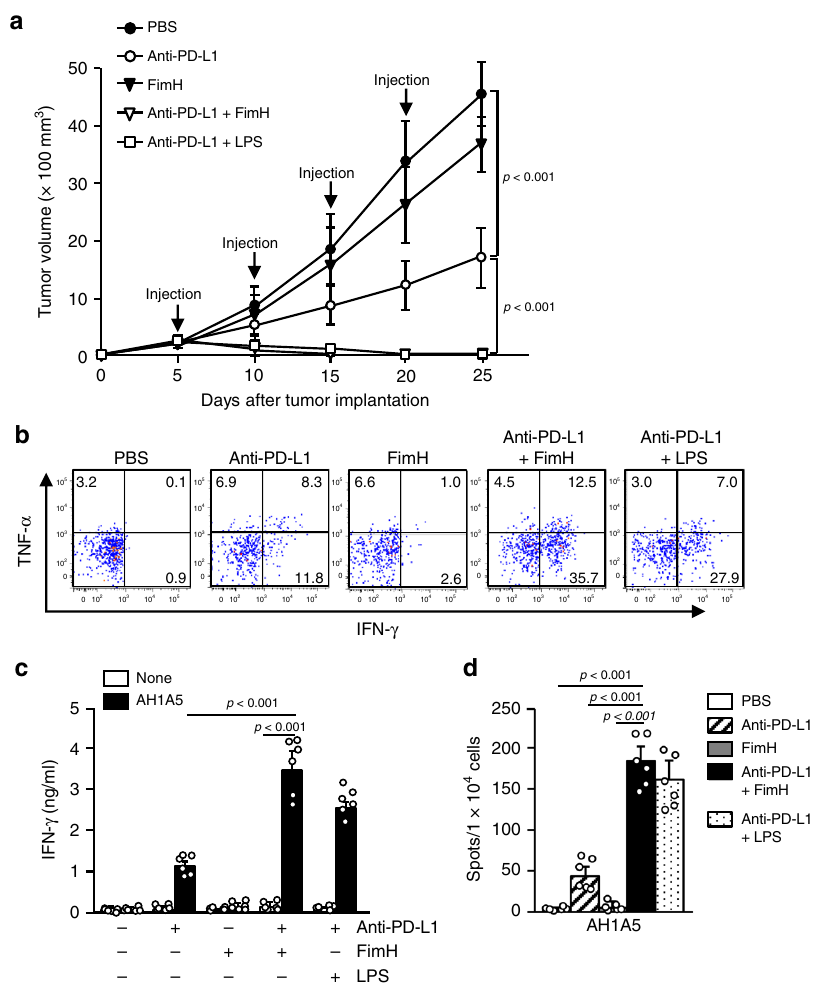
Fig. 7 Enhancement of the anti-cancer effect of anti-PD-L1 antibodies (Abs) by additional treatment of FimH. BALB/c mice were injected s.c. with 1 × 10 6 CT26 carcinoma cells. Five days after tumor injection, mice were treated i.p. with 10 mg per kg anti-PD-L1 antibodies (Abs), 2.5 mg per kg of FimH, or a combination of anti-PD-L1 Abs and FimH for every 5 days. a The graph of CT26 tumor growth is shown. (n = 6 mice signi fi cance was determined by the log-rank test, mean ± SEM). b Intracellular IFN- γ and TNF- α producing CD8 T cells in the tumor are shown. c Concentration of IFN- γ in cultured medium from AH1A5 peptide-treated tumor-drLN cells. ( n = 6 mice, two-way ANOVA, mean ± SEM). d AH1A5 peptide-speci fi c IFN- γ production was measured in tumor drLN by ELISpot analysis. ( n = 6 mice, one-way ANOVA, mean ±